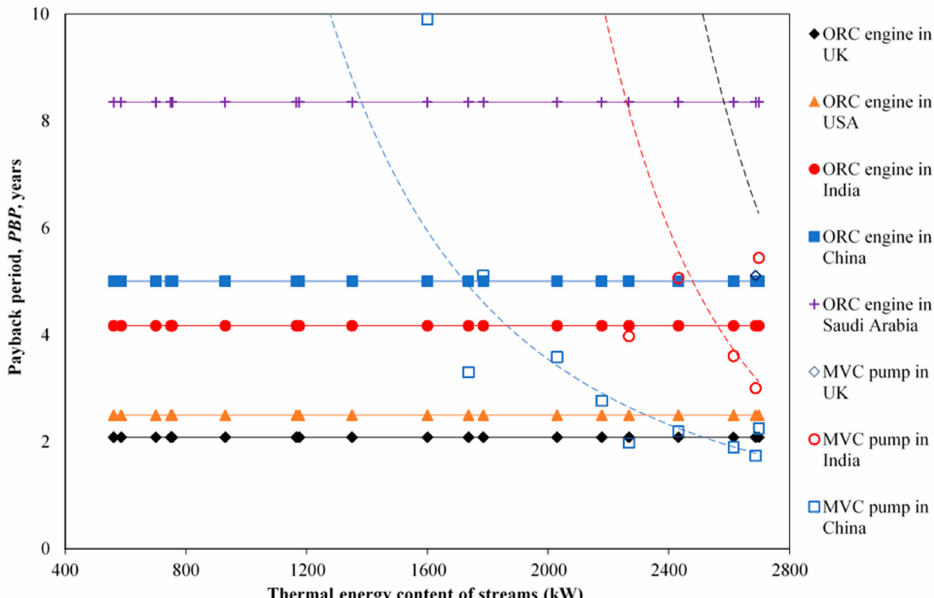
Figure 16. Payback periods associated with the use of ORC engines and MVC heat pumps in various countries as a function of the thermal-energy content of the streams when utilizing the thermal energy available in the streams listed in Table 5. The heat sink is at 25 ◦ C for the ORC engines, and 150 ◦ C (LP steam) is produced for the MVC heat